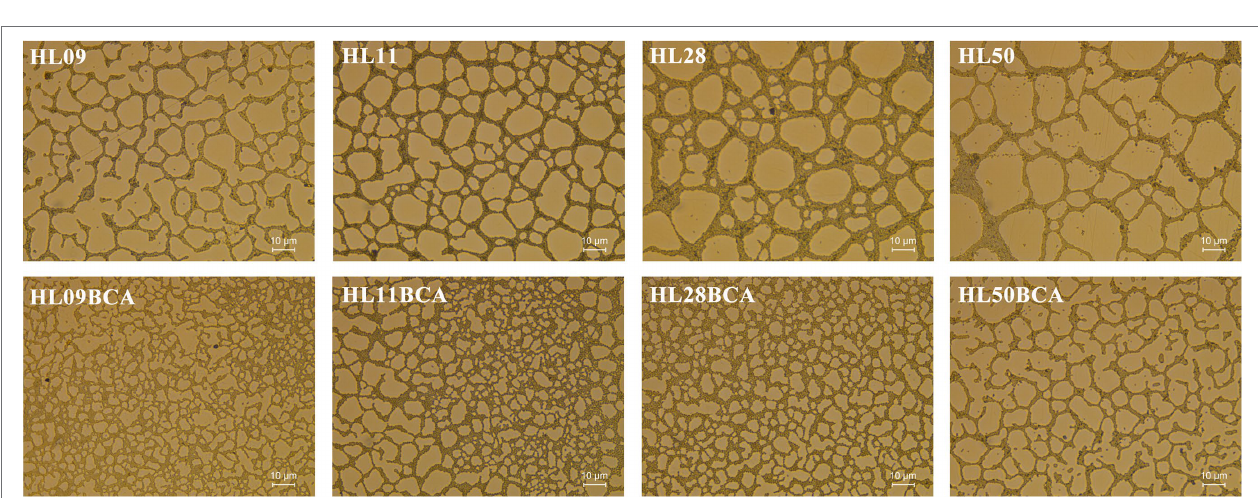
FIGURE 3 | Inverted microscopic analysis of Listeria monocytogenes biofilm. All biofilms were grown at 37 ° C for 48